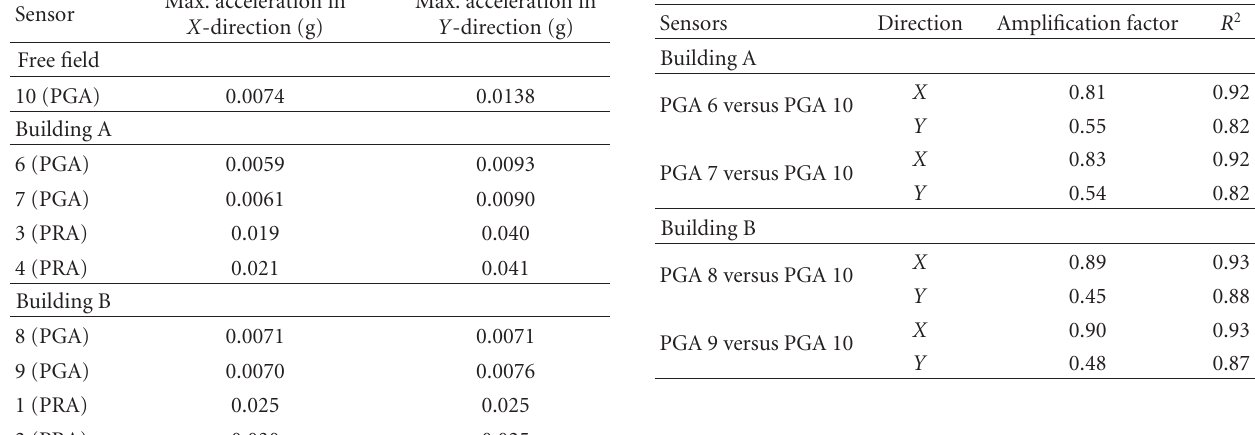
Table 2: Amplification factors between PGA at the building base and PGA at the free field